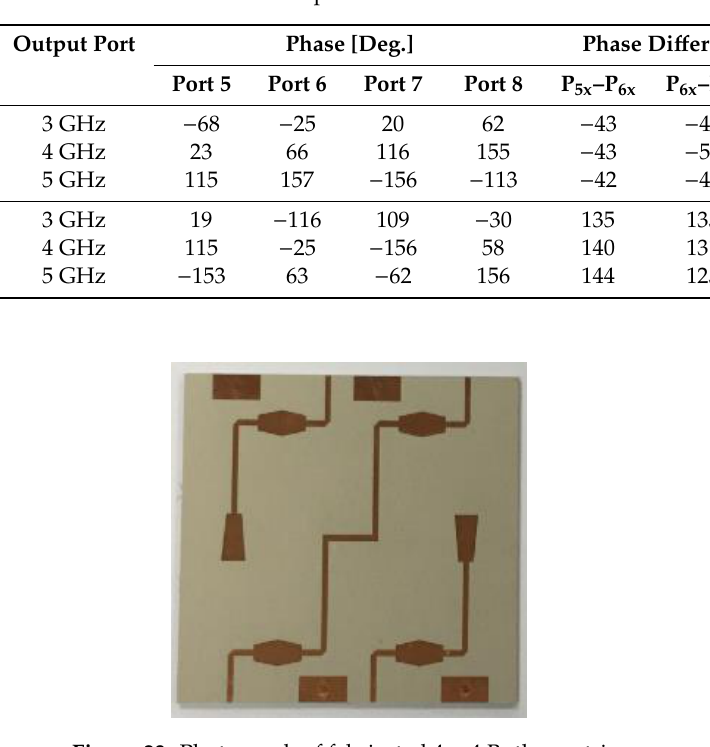
Figure 23. Photograph of fabricated 4 × 4 Butler matrix.